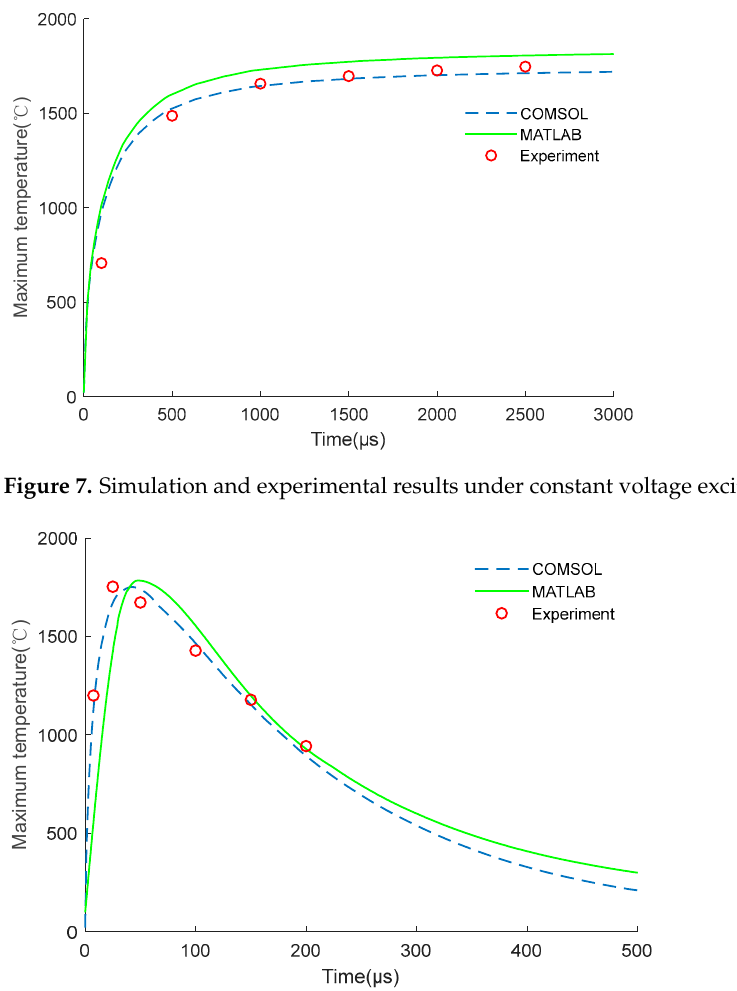
( b ) Figure 6. External excitation circuit. ( a ) Constant voltage excitation; ( b ) Capacitor discharge excita- tion. In order to analyze the effectiveness of the theoretical analysis of energy conversion, the conversion performance of the EC element, shown in Figure 5, was studied through theoretical analysis and the commercial software COMSOL. According to the physical field involved in the model of the EC element, the software adjusts the mesh based on the geometric structure, refines the cell size and generates a tetrahedral mesh. Moreover, the grid near the corner of the EC element is dense, while the grid at the other parts is sparse. In the calculation model, the surface nodes at both ends of the brazed pad were gal- vanically coupled. The influence of air convection and thermal radiation on the heat dis- tribution was also considered. Here, set the air thermal convection coefficient of all exter- nal surfaces of the EC element model was set as 10 W/(m 2 °C) and the ambient temperature